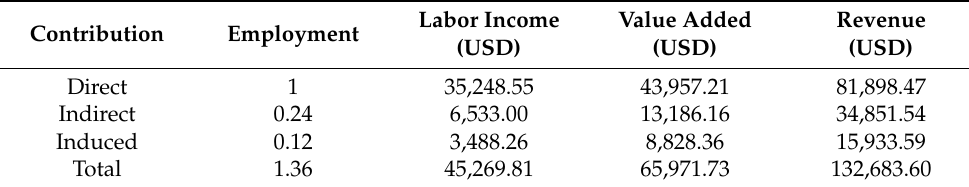
Table A23. Contribution of Partner Employment to Franklin County (Annual).